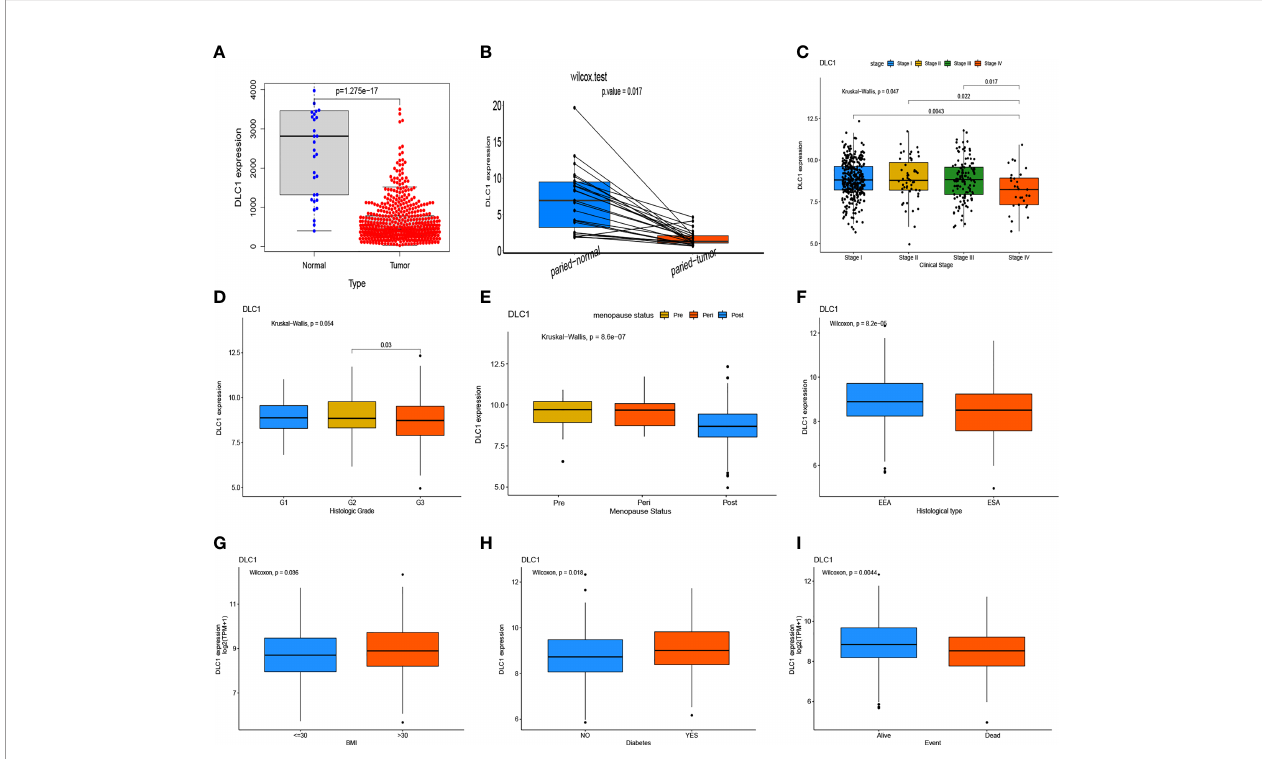
FIGURE 4 | Expression level of DLC1 in samples and its correlation with the clinical characteristics and survival of patients with uterine corpus endometrial carcinoma (UCEC). (A) DLC1 expression in the normal and tumor samples. Analyses were performed across all normal and tumor samples with P -value close to zero using the Wilcoxon rank-sum test. (B) Paired differentiation analysis for the DLC1 expression in the normal and tumor samples derived from the same patient ( P = 5.572602e − 05) using the Wilcoxon signed-rank test. (C – I) Relationship between DCL1 expression and clinical characteristics and survival. The statistical signi fi cance was calculated using the Kruskal – Wallis rank-sum test or Wilcoxon rank-sum